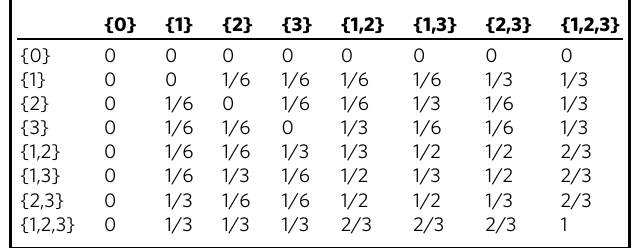
Table 1 The Shapley value of row coalition I to column coalition j when ϕ ii N ; v ð